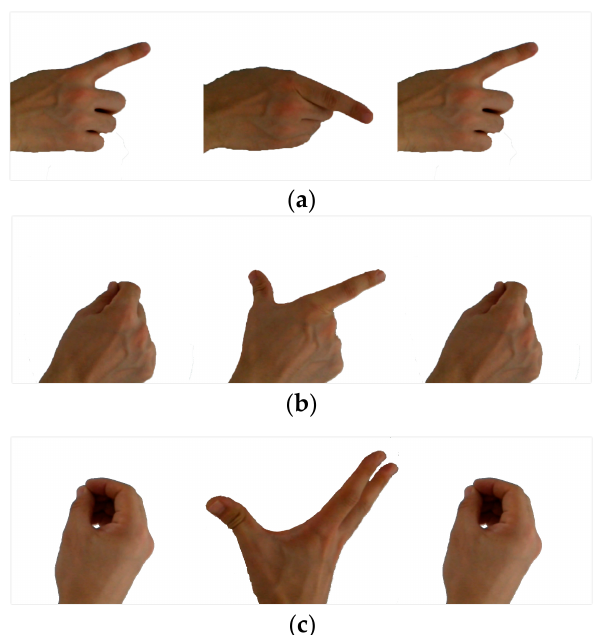
Figure 7. Start, middle, and end point of a gesture: ( a ) G1: Swing the index finger so that it is perpendicular to the radar line-of sight, from left to right, and then from right to left; ( b ) G2: Keep fingers in the direction of the LOS, pinch the thumb and index finger; ( c ) G3: Keep fingers in the direction of the LOS, pinch all fingers together and then spread them out, then pinch all the fingers together again.